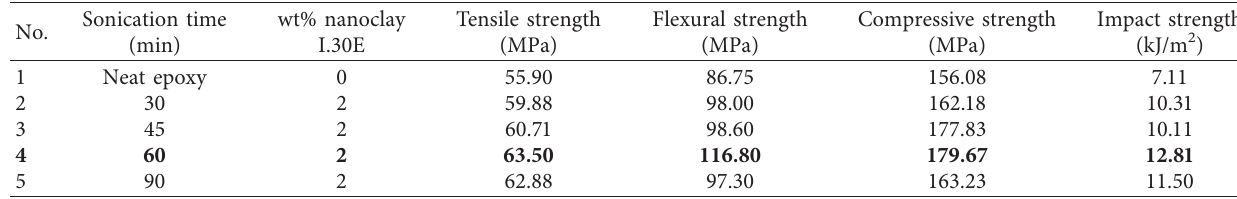
Table 7: Mechanical properties of epoxy Epikote 240/nanoclay I.30E nanocomposite materials.